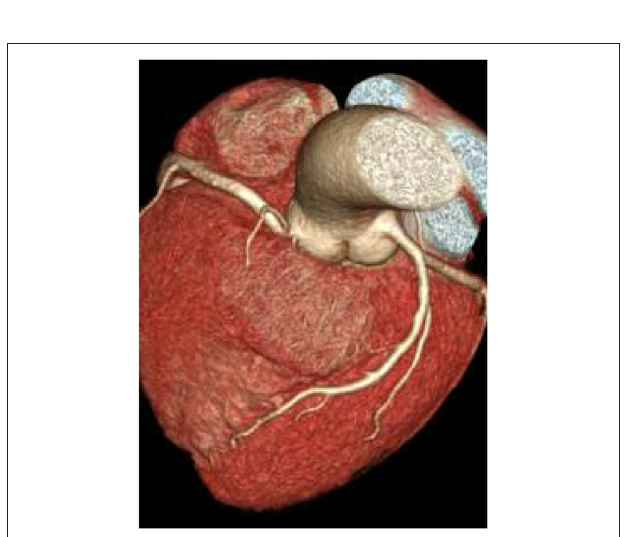
FIGURE 5 | Typical image of right coronary artery curved planar reconstruction in the observation group.